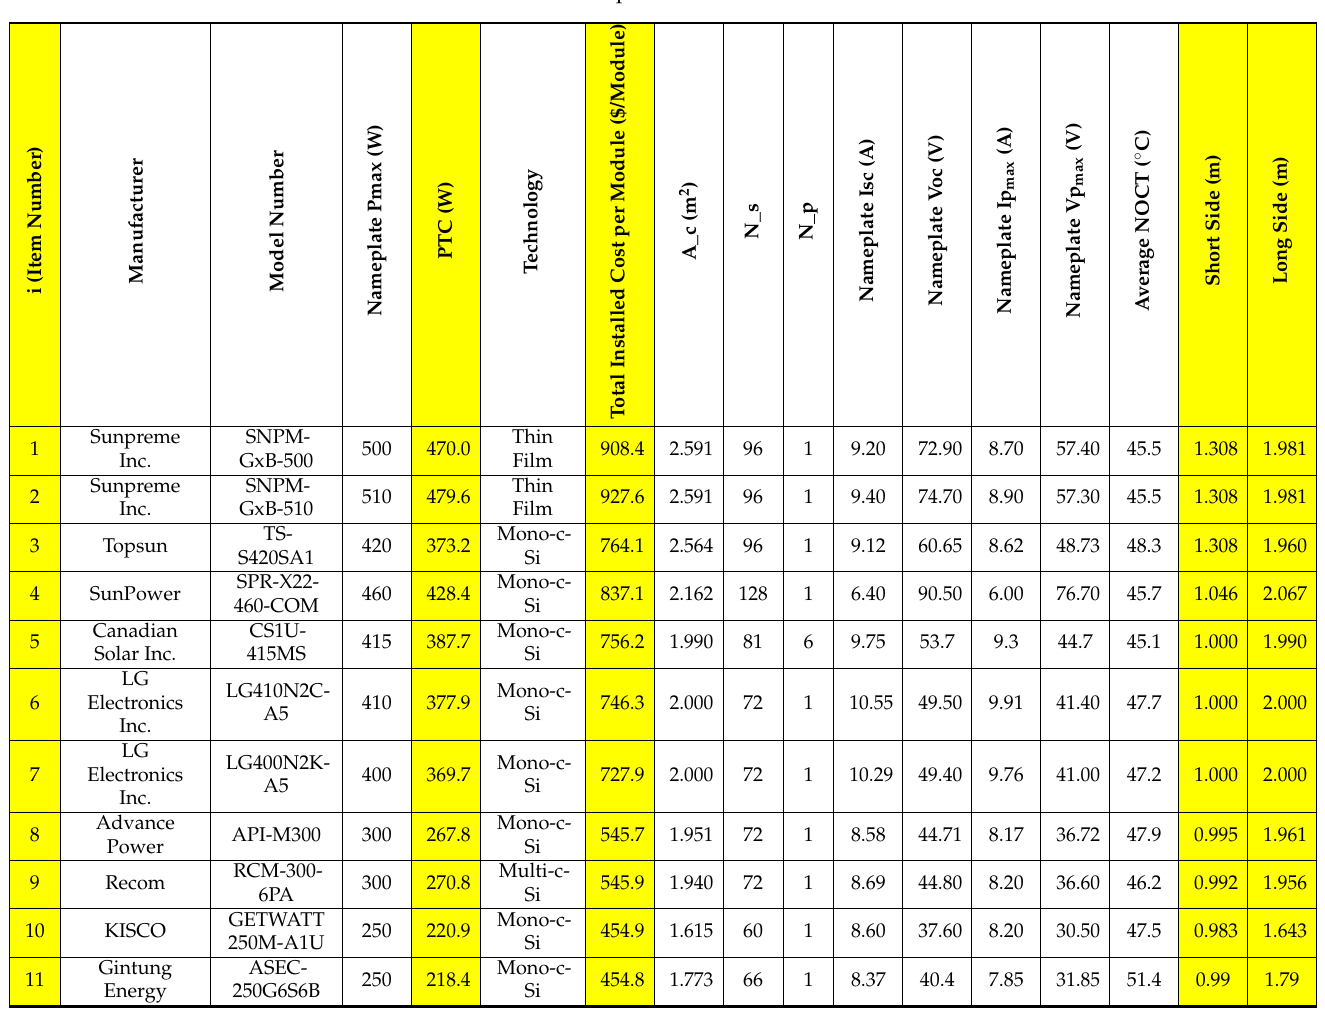
Table 1. Selected solar panels with their